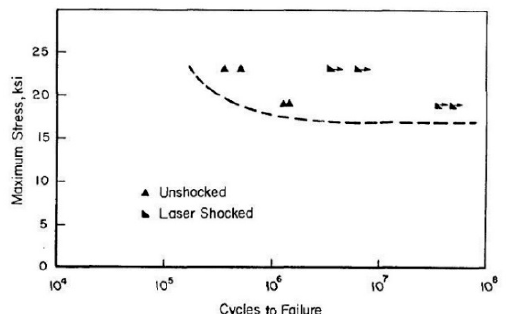
Figure 10. Effect of laser shocking on the fatigue life of welded 5456 aluminum, tension, R = 0. The dashed line represents the typical, unshocked tensile fatigue curve for this condition (10 ksi = 68.9 MPa) Reproduced with permission from [30], Springer US, 2019.